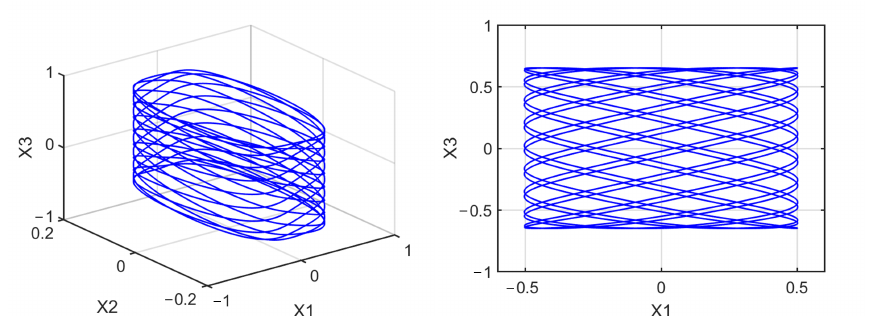
Figure A21. Periodic-17 motion of σ 1 = 6.6229.